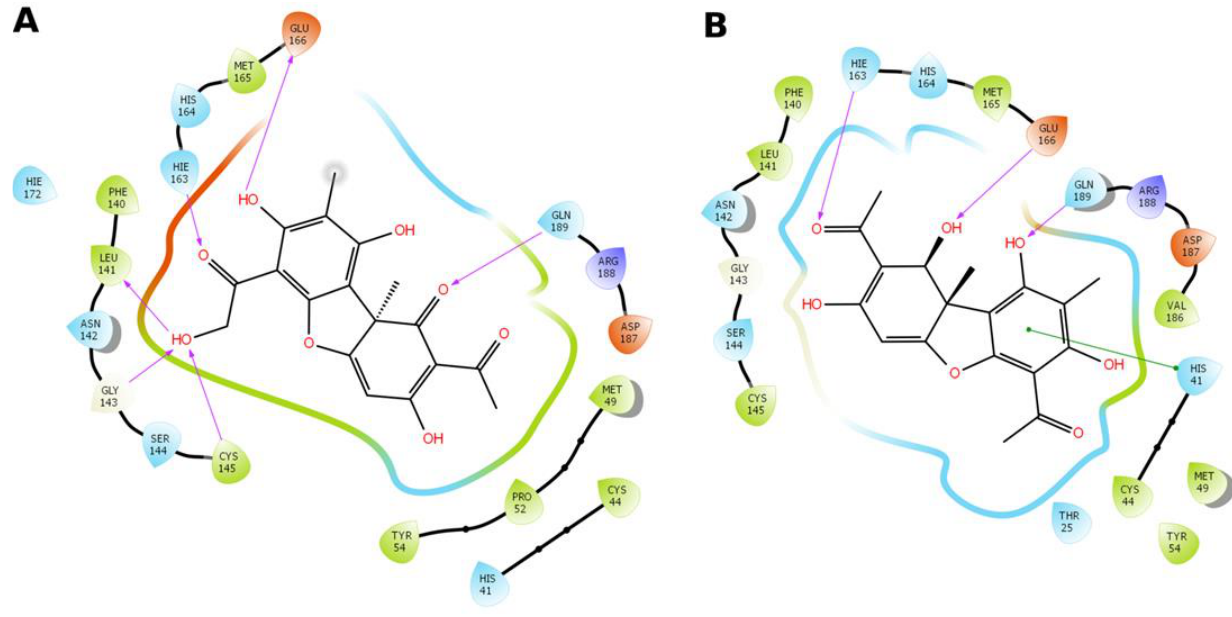
Figure 3. Noncovalent interactions of usnic acid derivatives at the active site of the main protease of SARS-CoV-2. ( A ) — agent 10 and ( B ) — agent 6 . Noncovalent interactions of co-compounds at the active site are shown with arrows: purple — hydrogen bonds and green — stacking interactions. Table 3. Inhibitory activity against pseudoviruses pseudotyped with S protein of Delta lineage